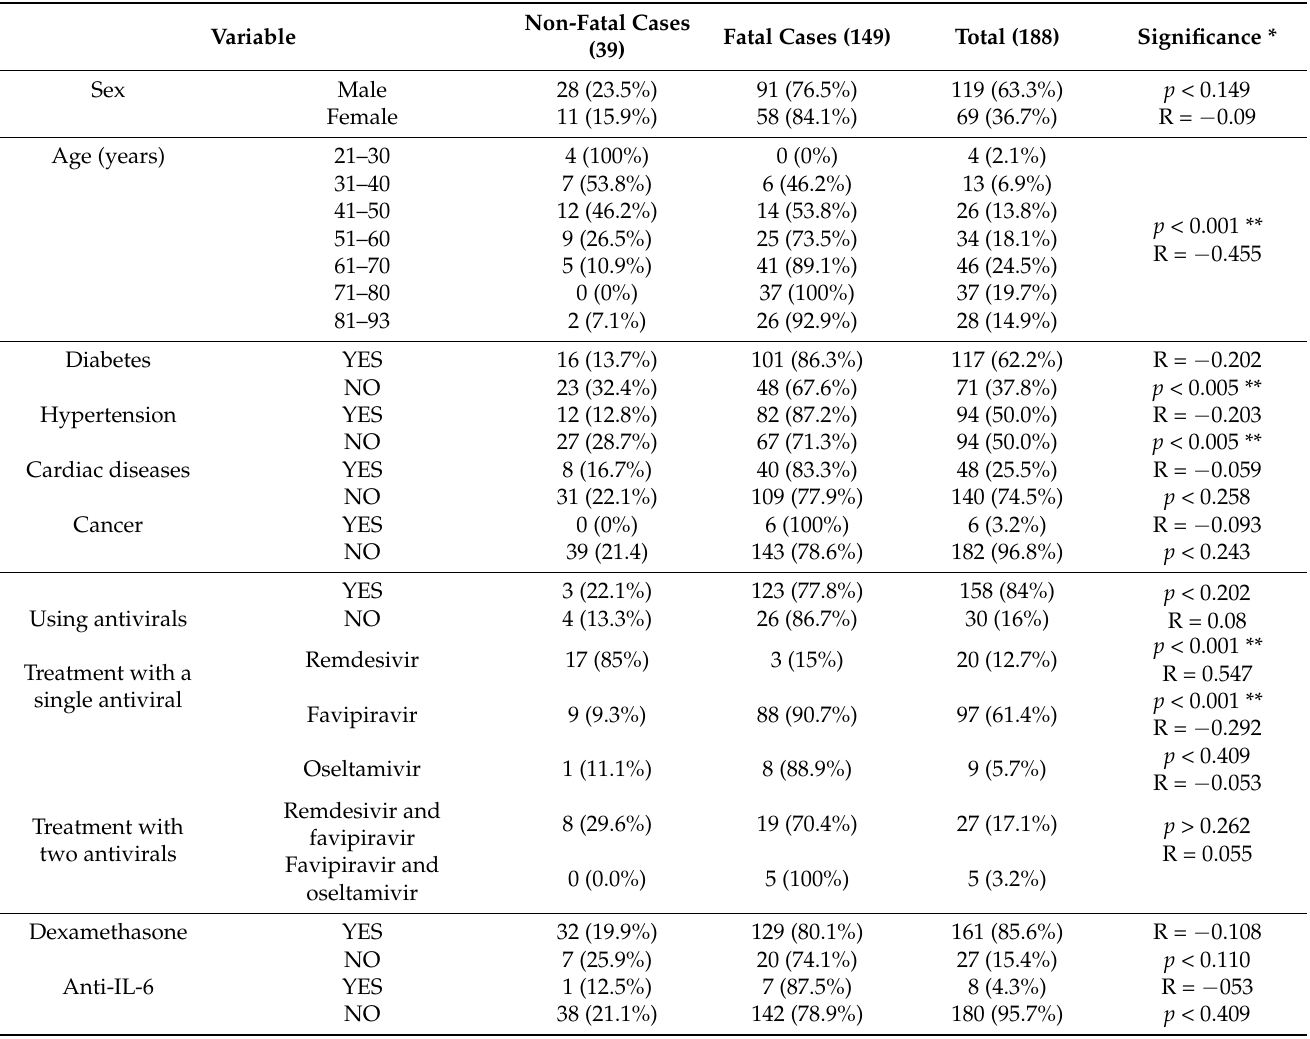
Table 1. Significance of age, sex, comorbidities, antiviral use, and supportive treatment on the survival rate of critical COVID-19